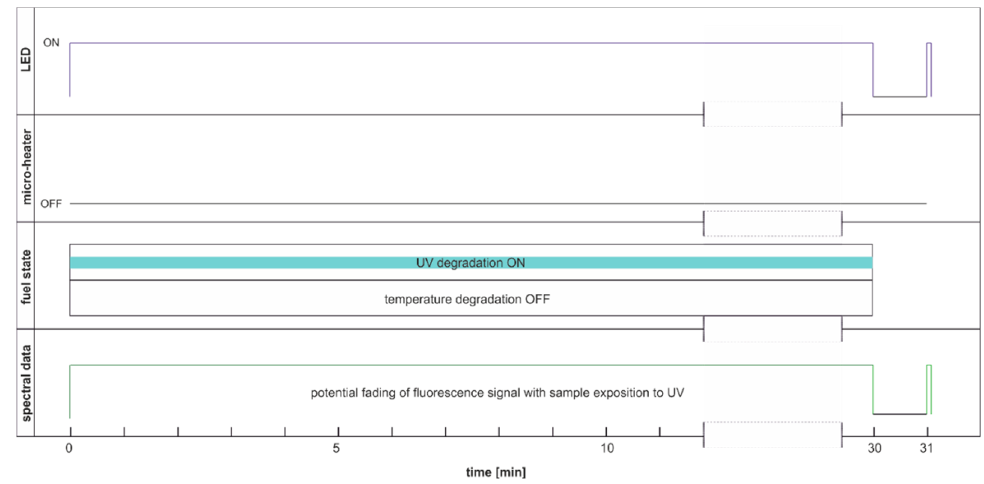
Figure 14. Degradation and examination cycle of fuel with UV use named DCE:UVonToff.